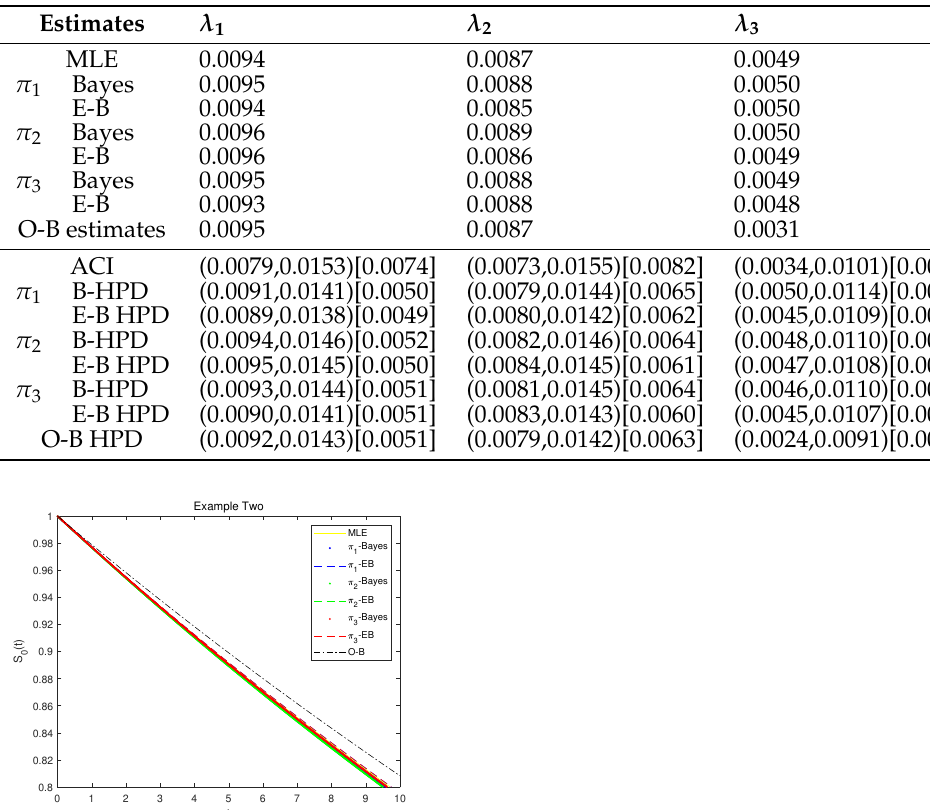
Table 8. Point and interval estimates of MOBE parameters under dependent HIV infection competing risks data.